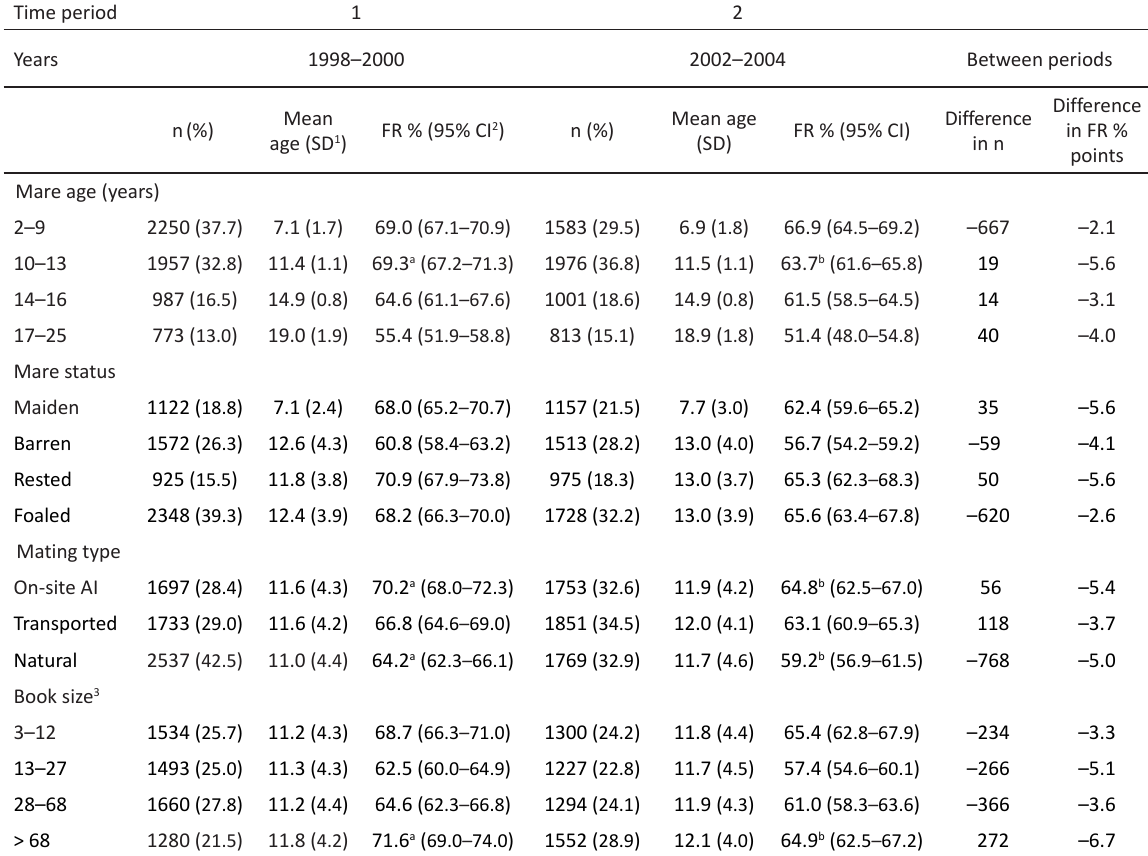
Table 1. Proportions, mean ages, and foaling rates (FR) of Finnhorse mares during two time periods, and the difference in the number of mating records (n) and in the FR percentage between these periods (period 2 minus period 1) Time period